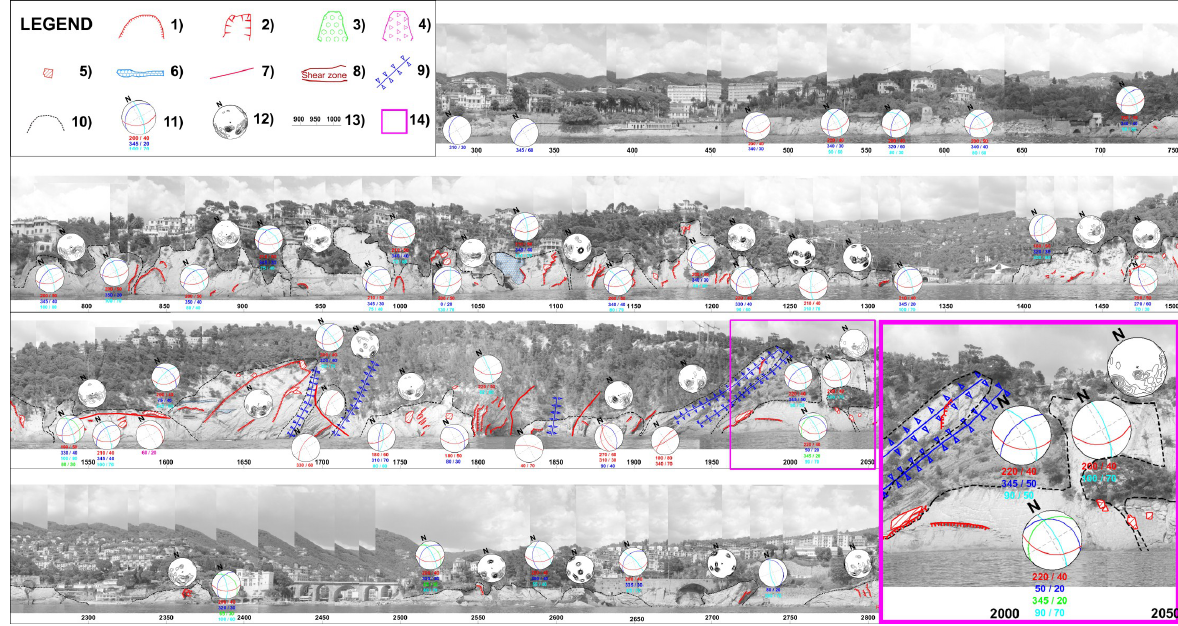
Fig. 6. Photographic view of the coastal stretch between Rapallo and Zoagli (Fig. 10a). Legend: (1) traces of detached rock blocks; (2) landslide crowns; (3) detrital deposits; (4) landslide accumulations; (5) unstable rock blocks; (6) remedial works for the mitigation of landslide hazard; (7) faults; (8) thrusts and shear zones; (9) folds axes; (10) survey areas for the systematic analysis of rock mass features; (11) discontinuity sets in the survey areas; (12) density plot of discontinuities in the survey area; (13) progressive distance from Rapallo (meters); (14) box of a zoomed